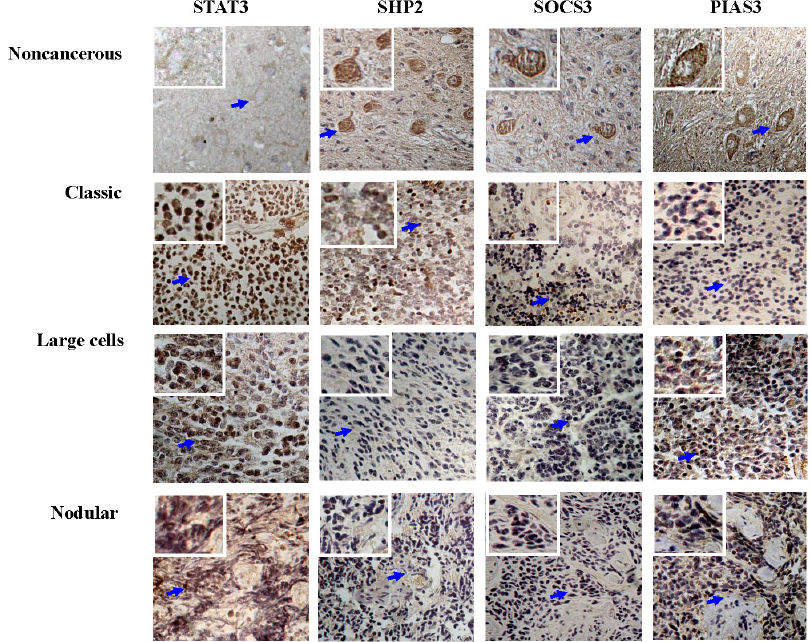
Figure 2. Immunohistochemical illustration (20×) of expression levels and intracellular distribution patterns of STAT3, SHP2, SOCS3 and PIAS3 in the three medulloblastoma subtypes and the tumor ‐ surrounding cerebellum tissues. The arrows indicate the regions shown in the insets with higher magnification (40×).